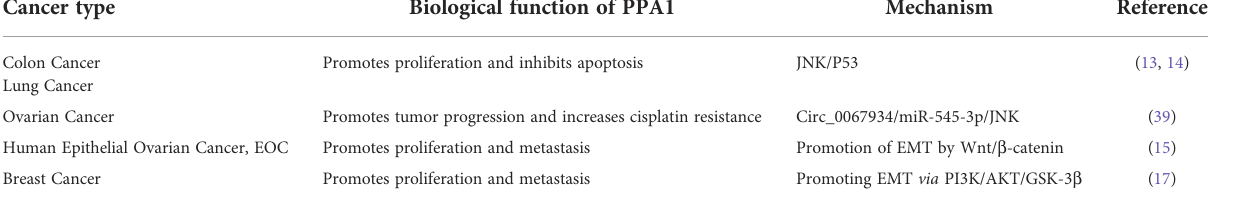
TABLE 1 Role of inorganic pyrophosphatase (PPA1) in tumor progression. Cancer type Biological function of PPA1 Mechanism Reference